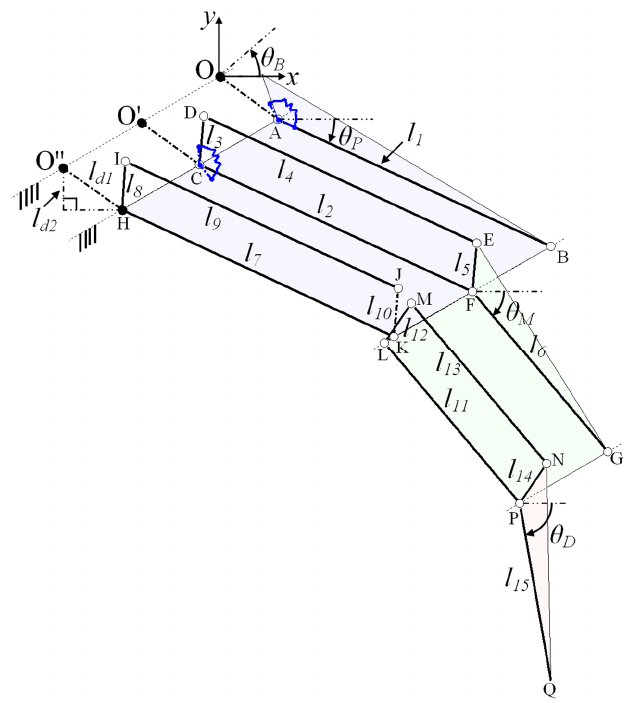
Figure 5. Kinematic parameters of the finger module.